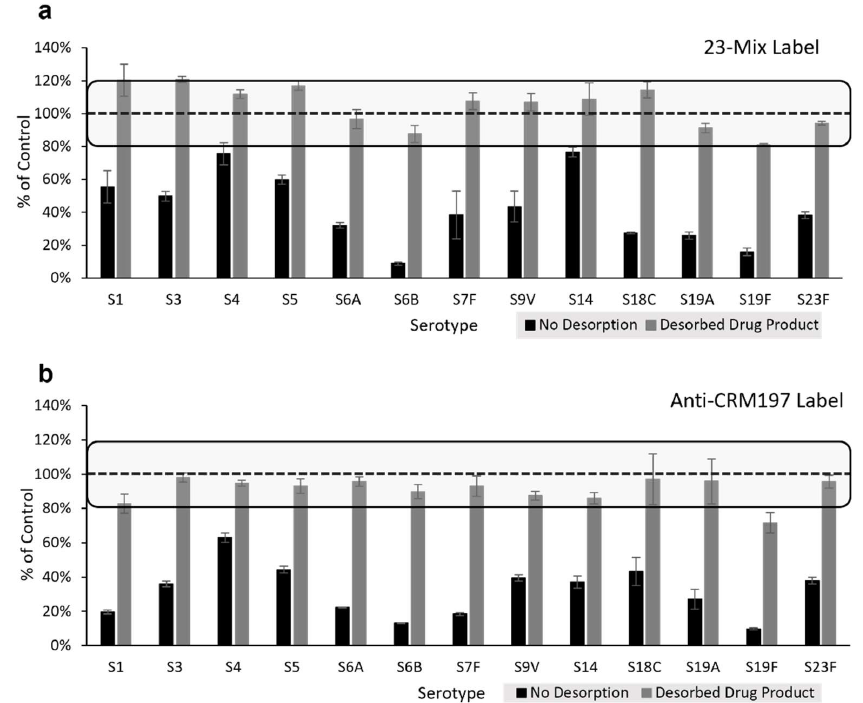
Figure 4. Pfizer 13-valent mock drug product signal before and after citrate desorption detected by 23-Mix Primary Detection Label ( a ) and anti-CRM197 Primary Detection Label ( b ). Results are from three independent citrate desorption experiments, and signals before and after desorption were normalized to the signal of un-adjuvanted drug substance analyzed at the same concentration. Error bars represent ± 1 standard deviation. Dashed lines indicate 100% of control, with the square boxes highlighting %recovery of 80–120%. Table 5. Accuracy and precision for desorbed Prevnar 20 TM using both 23-Mix and anti-CRM197 Primary Detection Labels. Expected concentration of each serotype is 0.2 µ g/mL (except S6B, which is present at 0.4 µ